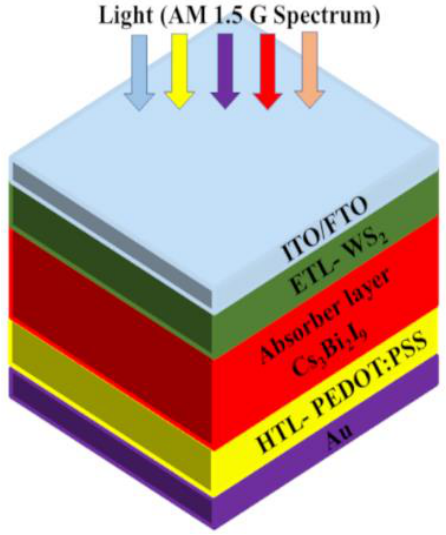
Figure 1. A typical model of a perovskite solar cell with different layers.